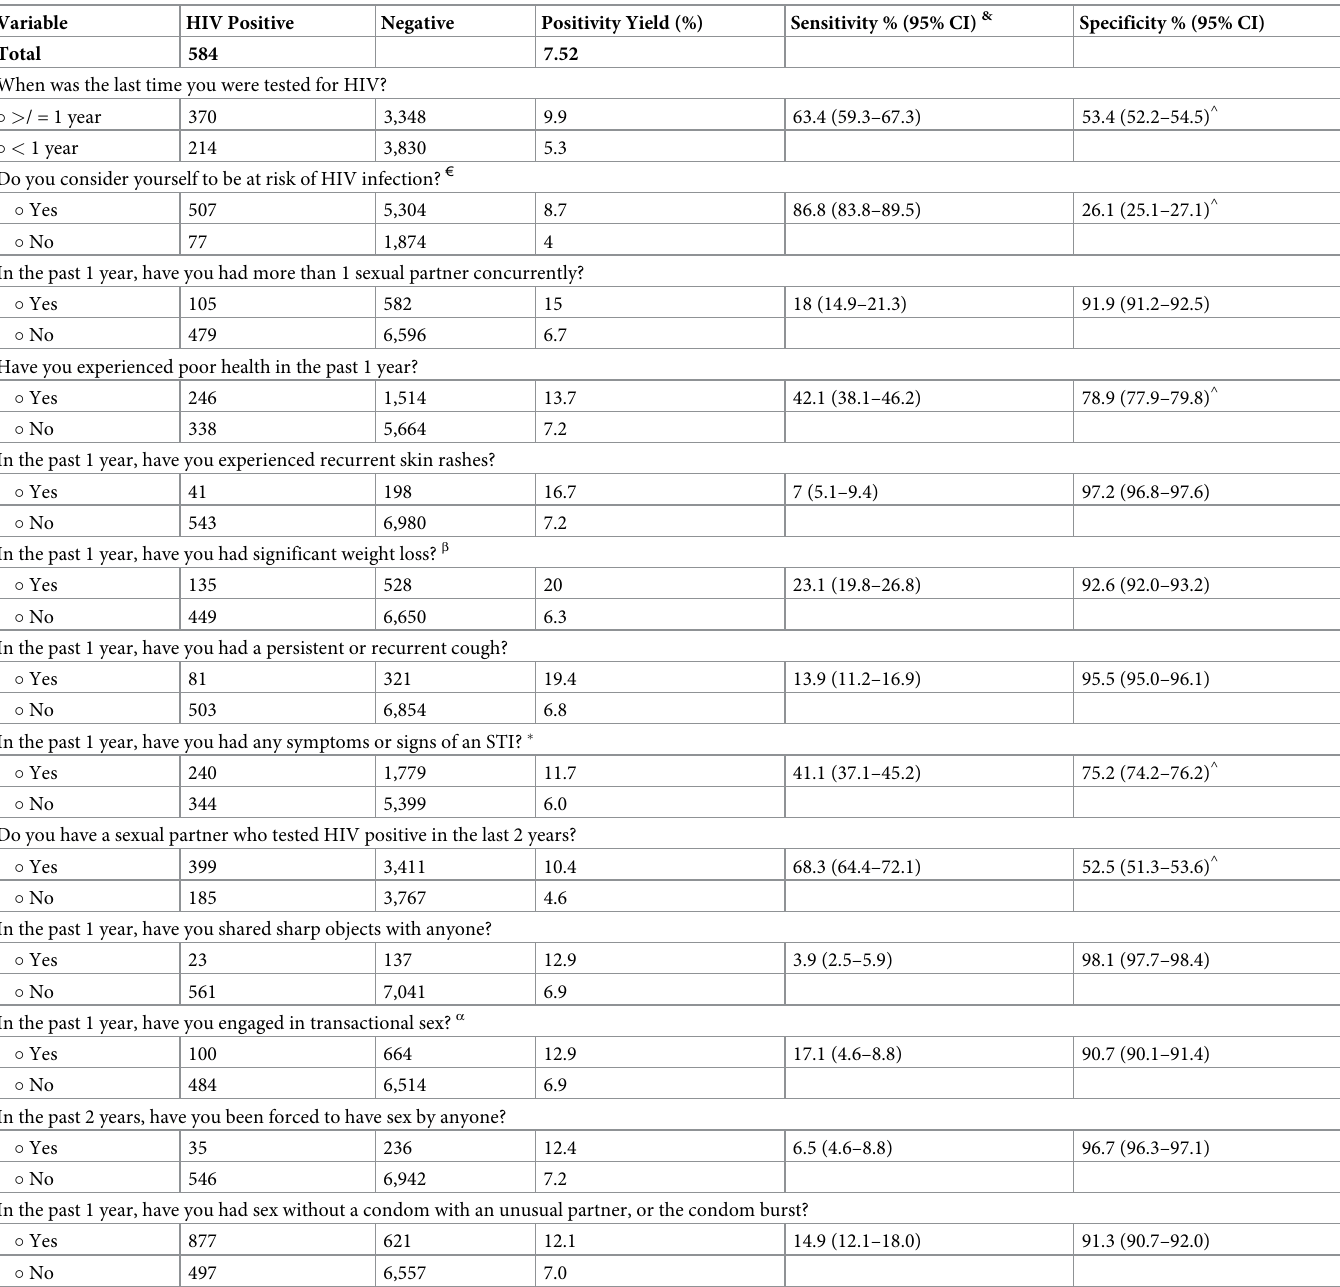
Table 1. Sensitivity and specificity for preliminary screening questions, Zimbabwe, 2021. (N = 7,825)